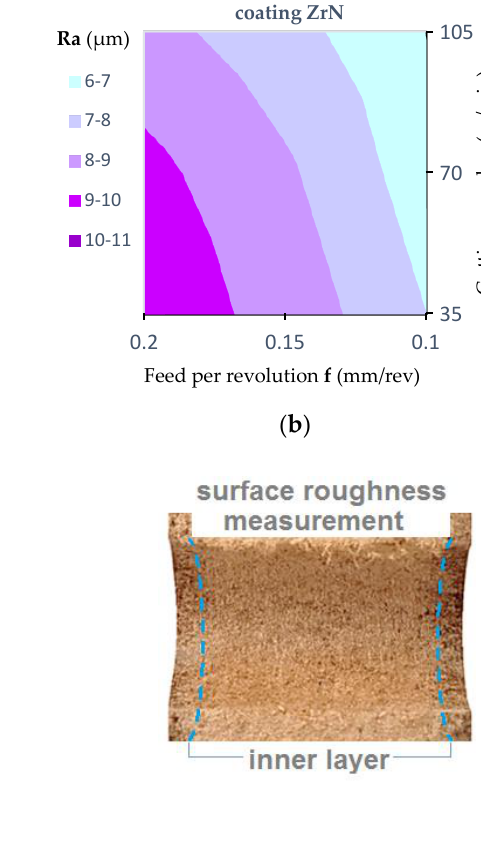
Figure 17. Influence of the feed value on the value of the surface roughness in the inner layer (contour 376